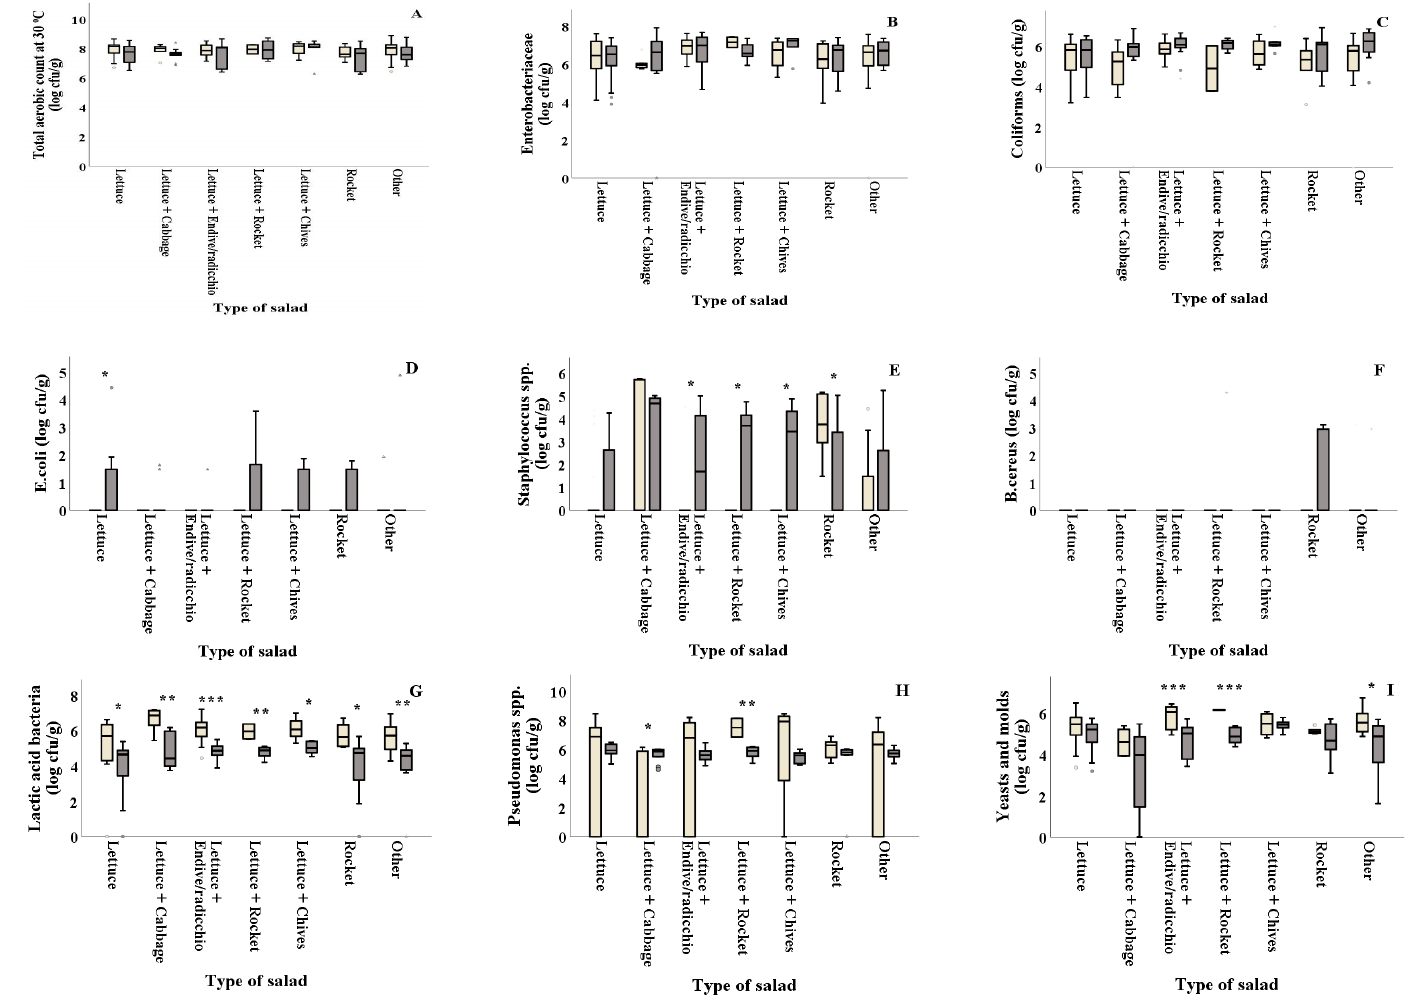
Figure 2. Microbiological quality ( A – I ) of different types of ready-to-eat salads collected in winter ( Figure 1 . Effect of season on the microbiological quality ( A – I ) of ready-to-eat salads collected in winter ( ) and summer ( ) among salad producers/packagers (A, B, C, D, and E). Results include Figure 1 . Effect of season on the microbiological quality ( A – I ) of ready-to-eat salads collected in winter ( ) and summer ( ) among salad producers/packagers (A, B, C, D, and E). Results include ). Results include only positive samples for each microorganism Figure 2. Microbiological quality ( A –I) of different types of ready-to-eat salads collected in winter ( ) and summer ( ). Results include only positive samples for each microorganism all samples for each microorganism tested and are the mean value ± standard deviation. Each box contains 50 percent of cases, and whiskers represent the rest. The line across the inside of the box all samples for each microorganism tested and are the mean value ± standard deviation. Each box contains 50 percent of cases, and whiskers represent the rest. The line across the inside of the box tested and are the mean value ± standard deviation. Other = lettuce + 2 or more ingredients. Each box contains 50 percent of cases, and whiskers represent the rest. The line across the tested and are the mean value ± standard deviation. Other = lettuce+2 or more ingredients. Each box contains 50 percent of cases, and whiskers represent the rest. The line across the inside of the box represents the median value. *, ** and *** indicate significant differences at p ≤ 5%, 1% and 0.1%. represents the median value. *, ** and *** indicate significant differences at p ≤ 5%, 1% and 0.1%. represents the median value. *, ** and *** indicate significant differences at p ≤ 5%, 1% and 0.1%. inside of the box represents the median value. *, ** and *** indicate significant differences at p ≤ 5%, 1% and